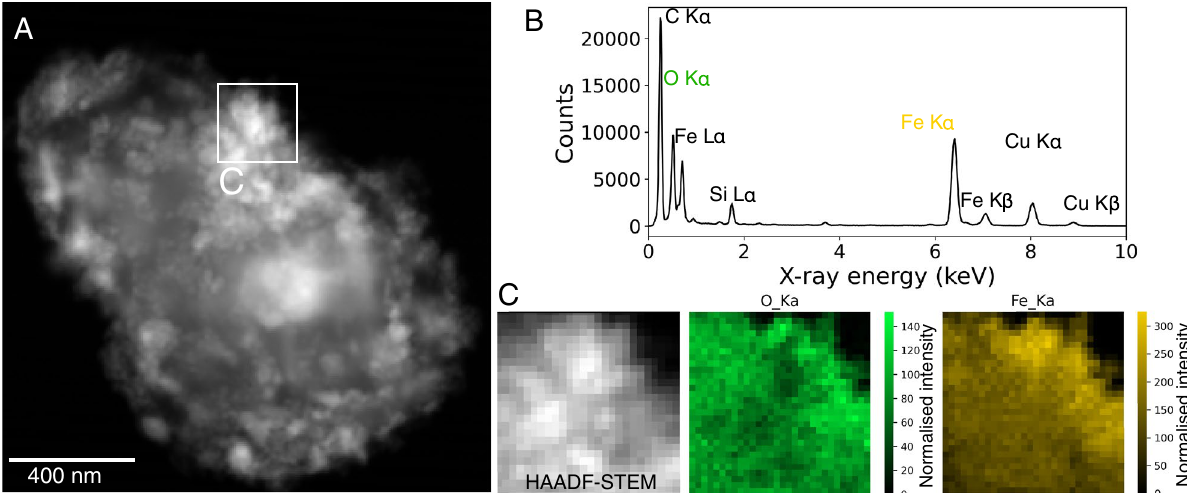
Figure 2. Morphological and chemical fingerprints of representative Fe-bearing particles from LU ( A ) HAADF-STEM imaging of Fe–O nanoparticles ( B ) EDS spectrum from Area C indicates signals from Fe and O, consistent with particles examined using SEM–EDS (see Supplementary Figs. S6–S8). ( C ) Elemental maps for Fe and O from the area of interest highlighted in